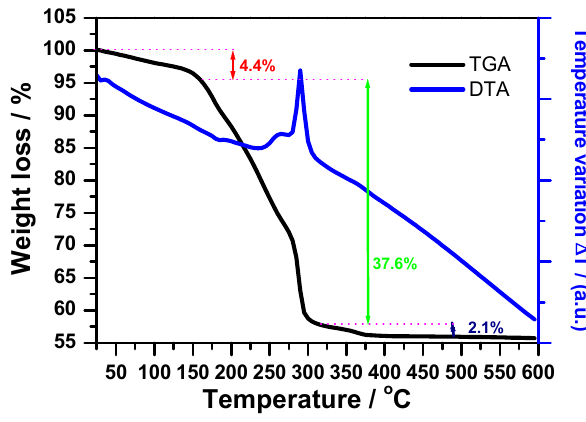
Figure 2. TGA and DTA thermograms recorded under air.